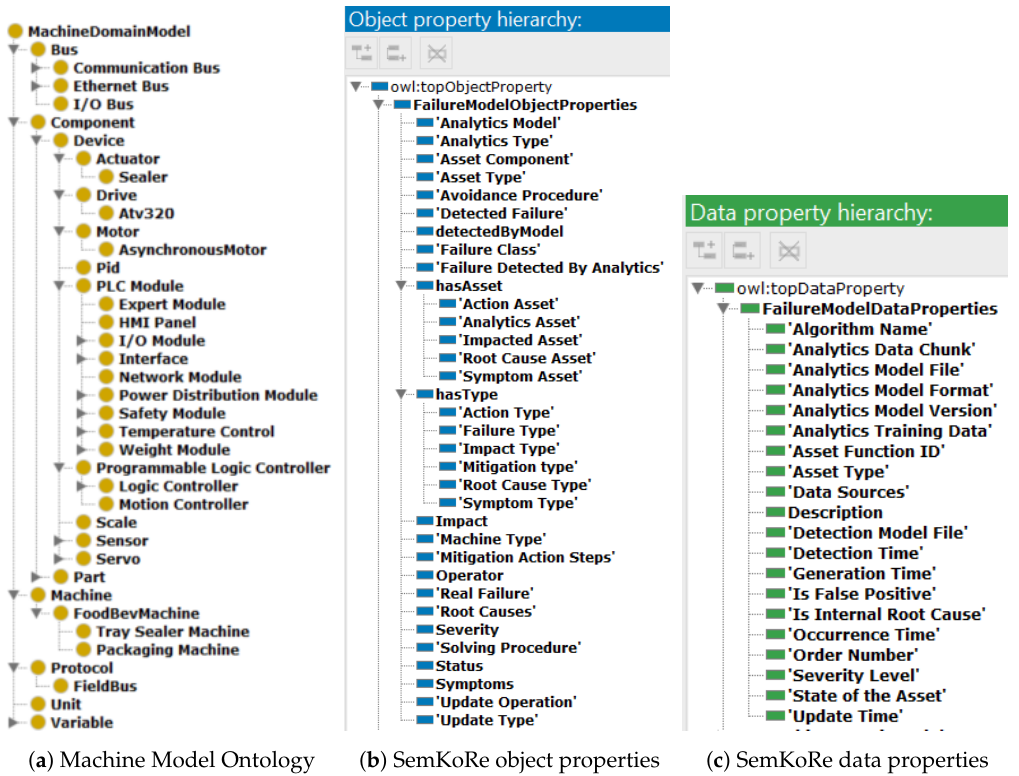
Figure 4. SemKoRe ontology